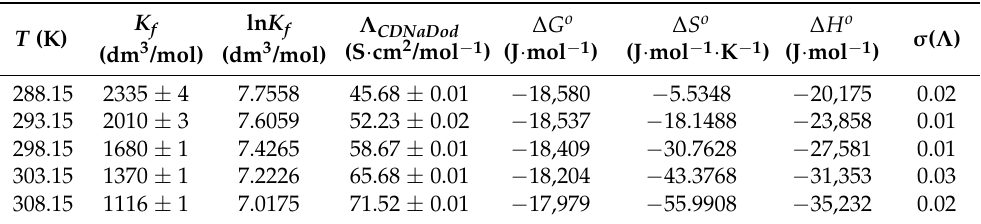
Table 5. The value of formation constant K f (dm 3 /mol), theoretical conductivity Λ CDNaDod (S · cm 2 /mol − 1 ) and the values of thermodynamic functions ∆ G o , ∆ H o and ∆ S o for α -cyclodextrin with the salt of trans -ferulic acid.